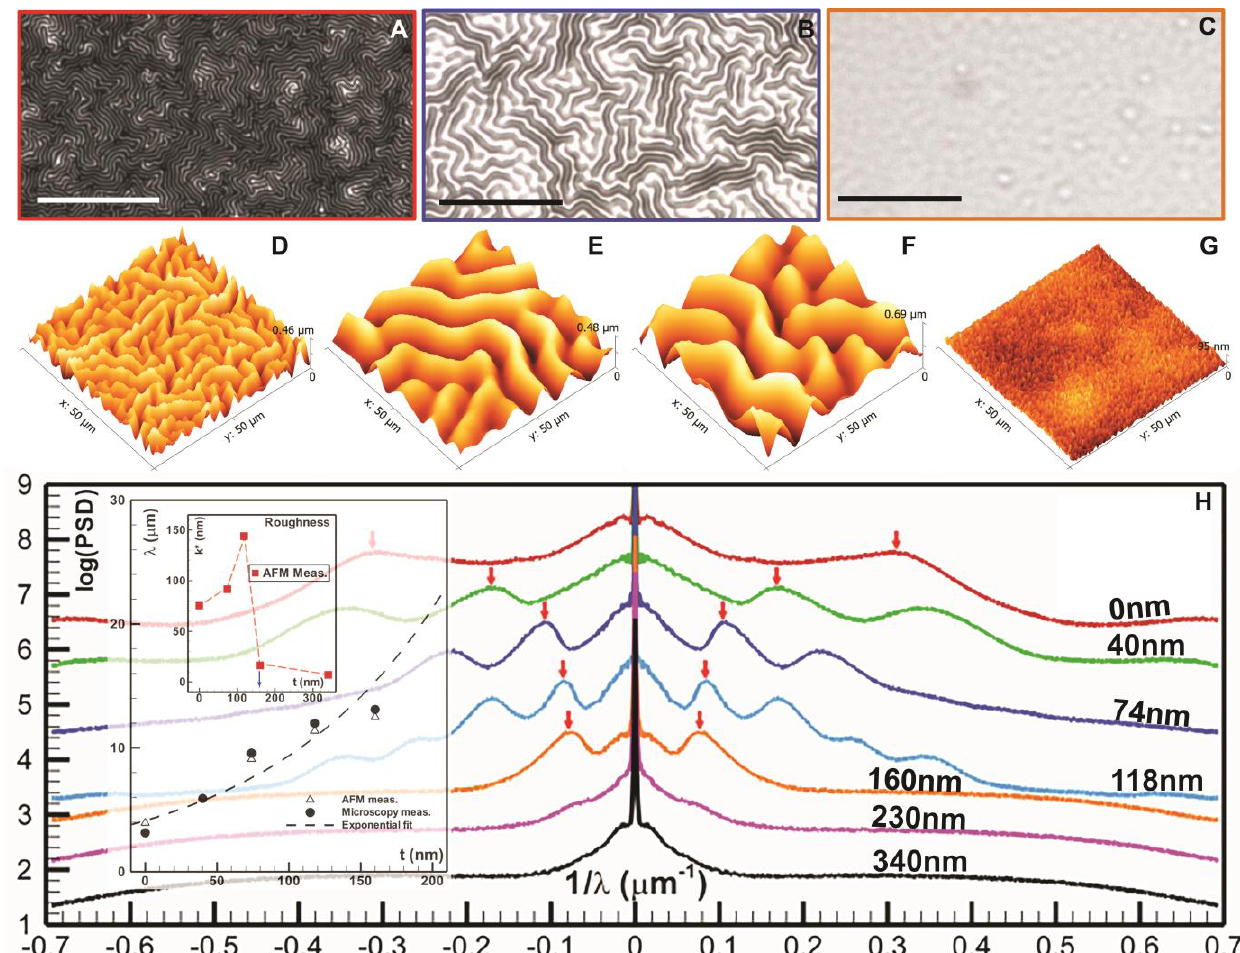
Figure 3. Topological characteristics of a 50 nm Al film over a 1.5 mm PDMS substrate pre-coated with various jammer thickness, 𝑡 . Top row: micrographs of surface roughness of the Al-PDMS bilayer with 𝑡 = ( A ) 0, ( B ) 74, & ( C ) 160 nm. Middle row: 50 × 50 μm AFM roughness images with 𝑡 = ( D ) 0, ( E ) 74, ( F ) 118 nm, and ( G ) 340 nm. ( H ) radial power spectra density (rPSD) of surface roughness. rPSDs are artificially shifted vertically for clarity. Label: 𝑡 . Arrows mark the characteristic wrinkle wavelength, 𝜆 . Insert: 𝜆 vs 𝑡 using both micrographs and AFM scans; and characteristic surface roughness 𝑘 ∗ vs 𝑡 using AFM measurements. Scale: 20 μm .